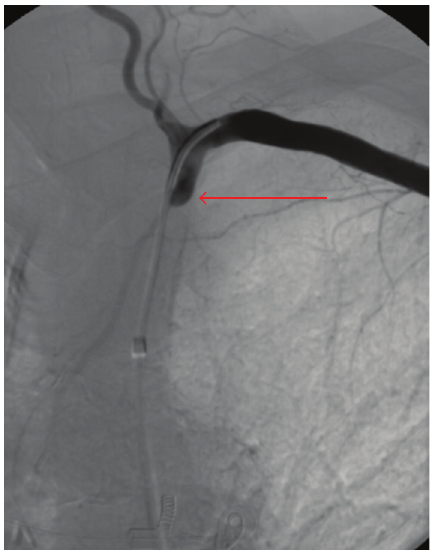
Figure 4: Angiography of the left subclavian artery after insertion of the guidewire (LIMA is not